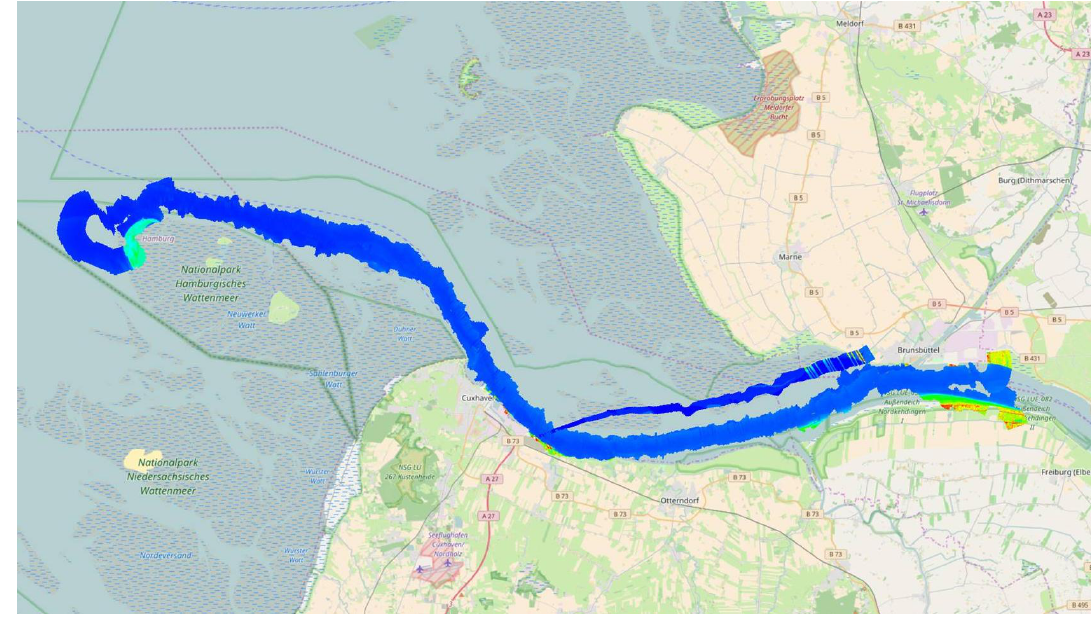
Figure 7. Mosaic of thermal images over the mouth of the Elbe during AMARO’s experimental core time.